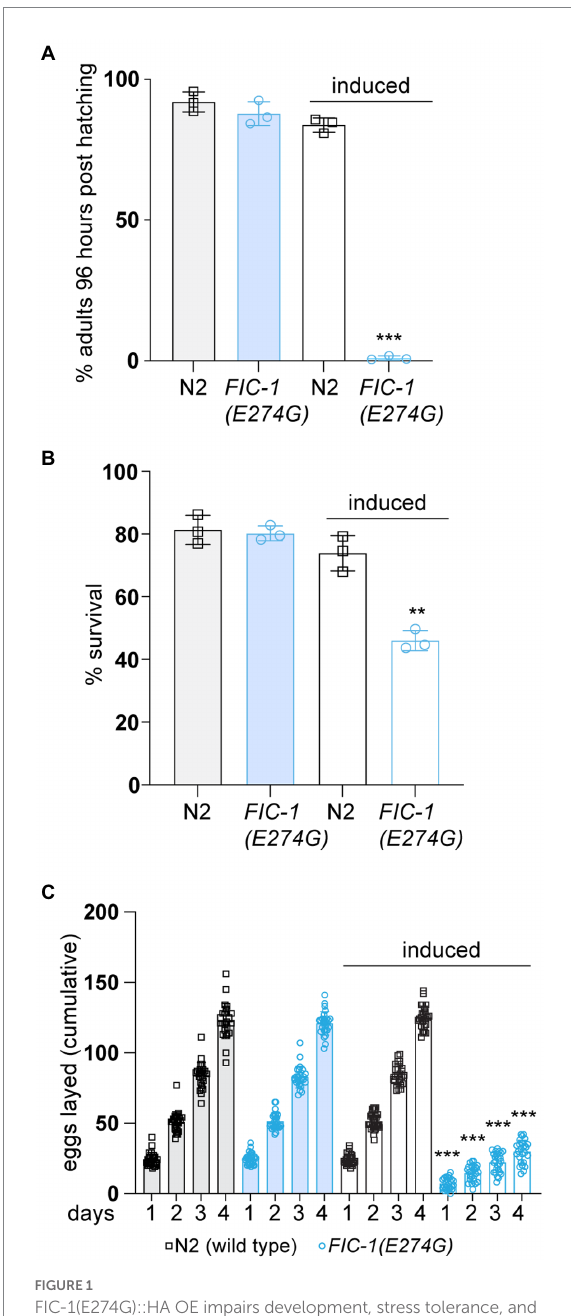
FIGURE 1 FIC-1(E274G)::HA OE impairs development, stress tolerance, and reproduction. (A) Induced and non-induced N2 and nIs774 eggs were placed on NGM culture plates and incubated at 20 ° C. After 96 h, number of adults was determined and compared to initial number of eggs on each plate ( n > 100/plate). (B) L4 animals were incubated at 30 ° C for 2 h. Following 30 min of recovery, worm survival was measured. (C) Egg laying of individual animals during the first 96 h of adulthood. Individually-kept animals (3 replicates, 9 animals per replicate/genotype) were transferred to fresh NGM growth plates in 24 h intervals and number of eggs was quantified by microscopy. For (A,B) : Each datapoint represents a biological replicate with >100 animals per replicate and condition. Error bars represent SD. Statistical significance ( p -values) were calculated using unpaired t -tests, comparing induced N2 with induced nIs774 groups. ** p < 0.01, *** p < 0.001, not significant (ns) p >